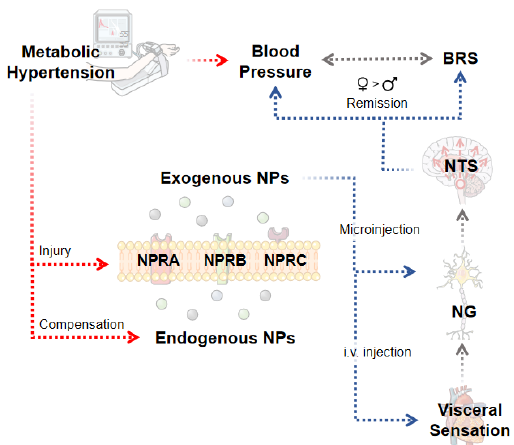
Figure 7. Schematic diagram explaining natriuretic peptides (NPs)—mediated anti-hypertensive effects via baroreflex afferent pathway. This study confirmed that microinjection of NPs in the nodose ganglion (NG) can lower blood pressure under both physiological and pathophysiological status. Meanwhile, exogenous NPs can perform baroreceptor sensitivity (BRS) improvement effect. These anti-hypertensive functions and the expression of natriuretic peptide receptors (NPRs) were closely related to estrogen. Abnormal expression of NPs and its receptors in nodose ganglion (NG) and nucleus tractus solitarius (NTS) in models of hypertension with metabolic disorders suggests a negative feedback